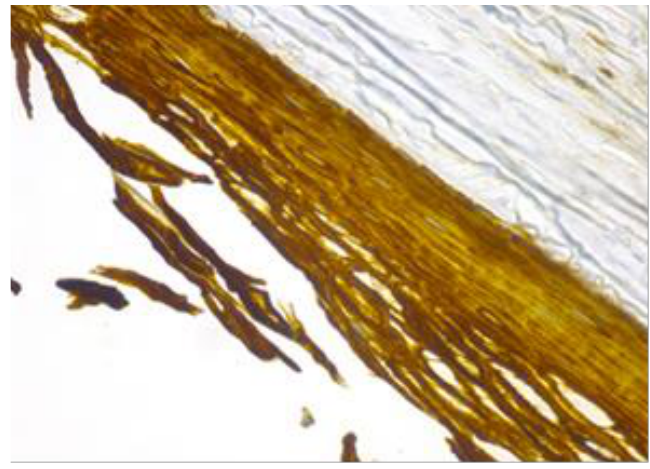
Figure 7. Cyst’s epithelium mark ed as intensively positive (CK 5/6, 40X).